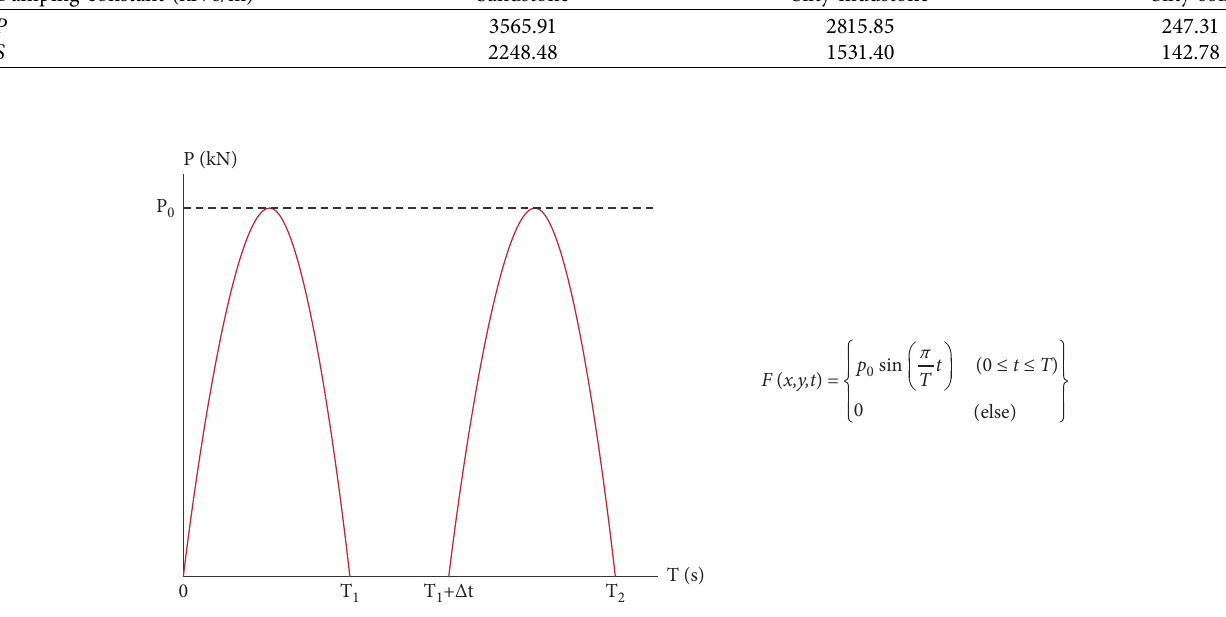
Figure 5: Sine traffic load